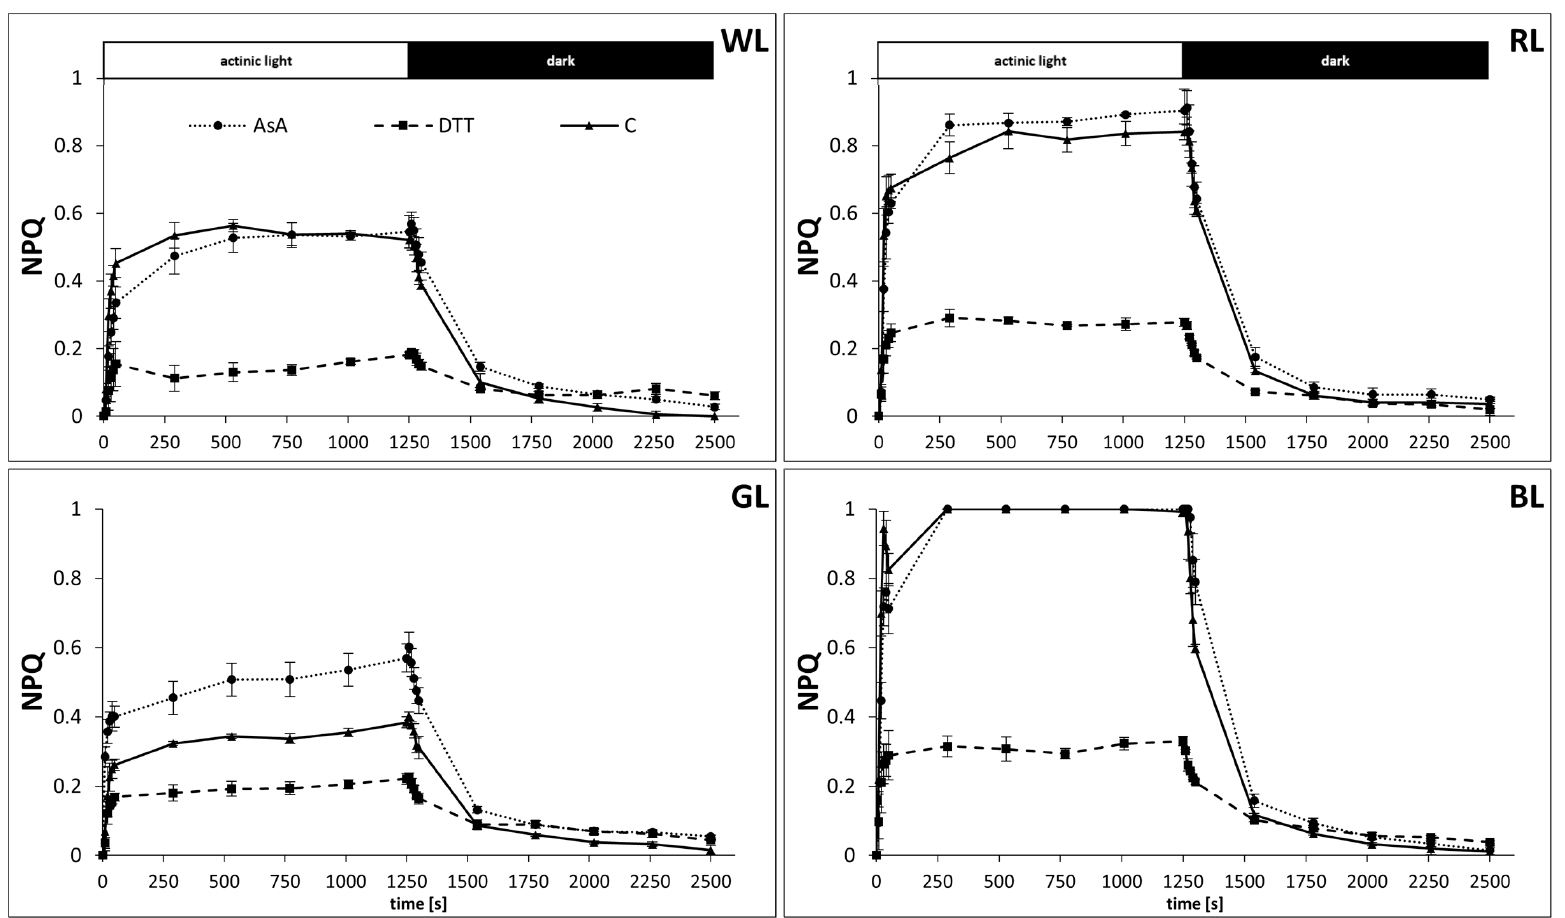
Figure 1. Dynamic changes of non-photochemical quenching, NPQ, in leaves of tomato plants ( Solanum lycopersicum L. cv. Malinowy Ozarowski) grown under different LED light conditions (see Material and Methods for details). 10 mm diameter leaf discs were infiltrated with 10 mM ascorbic acid (AsA) or 5 mM dithiothreitol (DTT), or distilled water (C, control) for 30 min in the dark, followed by pre-illumination at 500 µmol m –2 s –1 of RGB light for next 30 min. The dynamics of the NPQ were determined in re-darkened leaf samples illuminated for 20 min at 185 µmol m –2 s –1 of blue actinic light (AL = 450 nm) (induction), followed by 20 min of dark incubation (relaxation), and derived from the maximum fluorescence induced by saturation pulses (5000 µmol m − 2 s − 1 , 0.8 s) at each of the measuring points. Each data point represents the average ± SD of six independent measurements ( n = 6).